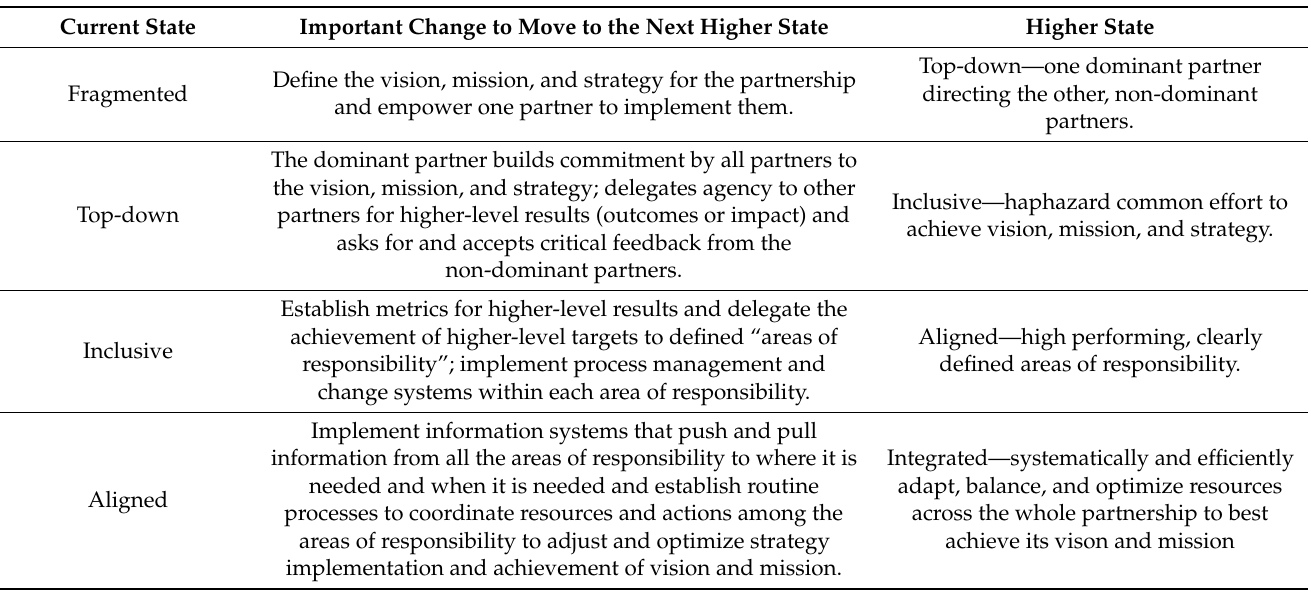
Table 6. Examples of organizational changes to move up the